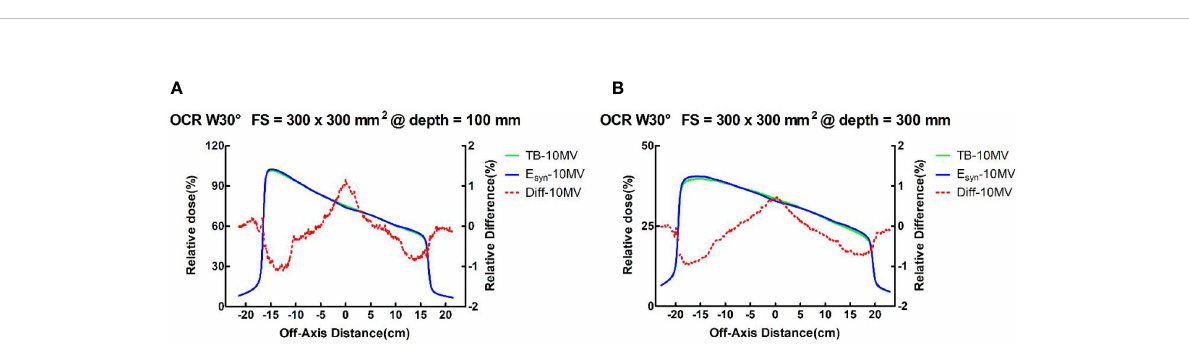
FIGURE 4 TB-10MV and E syn -10MV OCRs and differences for the wedge 30° fi eld at size of 400 × 400 mm 2 at depths of (A) 100mm and (B) 300mm.